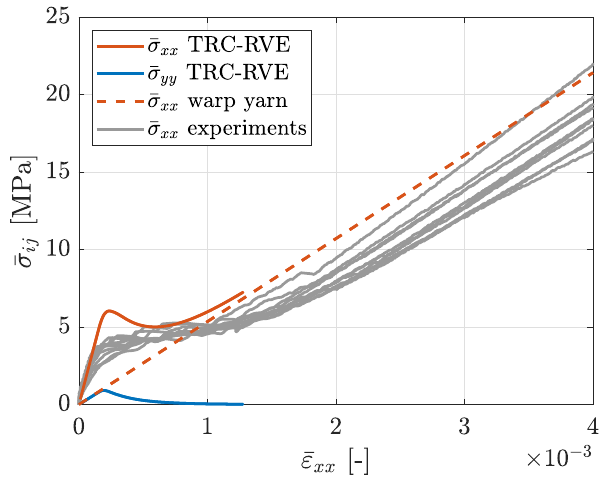
Figure 12. Effective macroscopic stress–strain relation due to tensile loading in warp yarn direction with prescribed strain ¯ (cid:101) = [ ¯ (cid:101) xx , ¯ (cid:101) yy = 0, ¯ γ xy = 0 ]